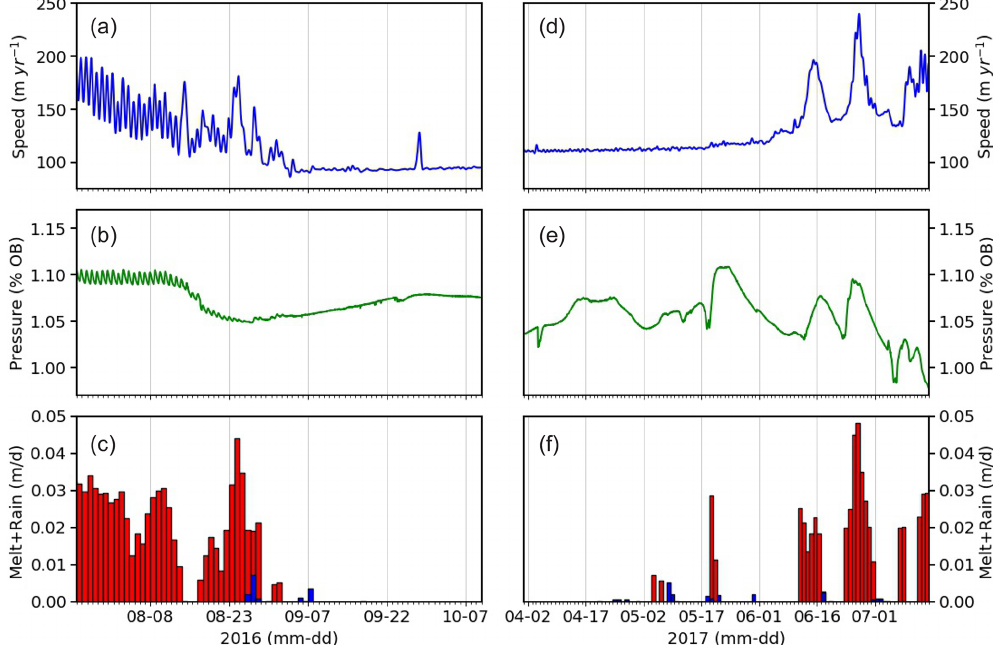
Figure 3. Time series of data collected at the 33km borehole site showing the start and end of the winter period: (a) – (c) winter onset; (d) – (f) winter termination. Melt is red, and rain is blue (c, f) . Borehole, GPS, and meteorological instruments are all located within 10m of each